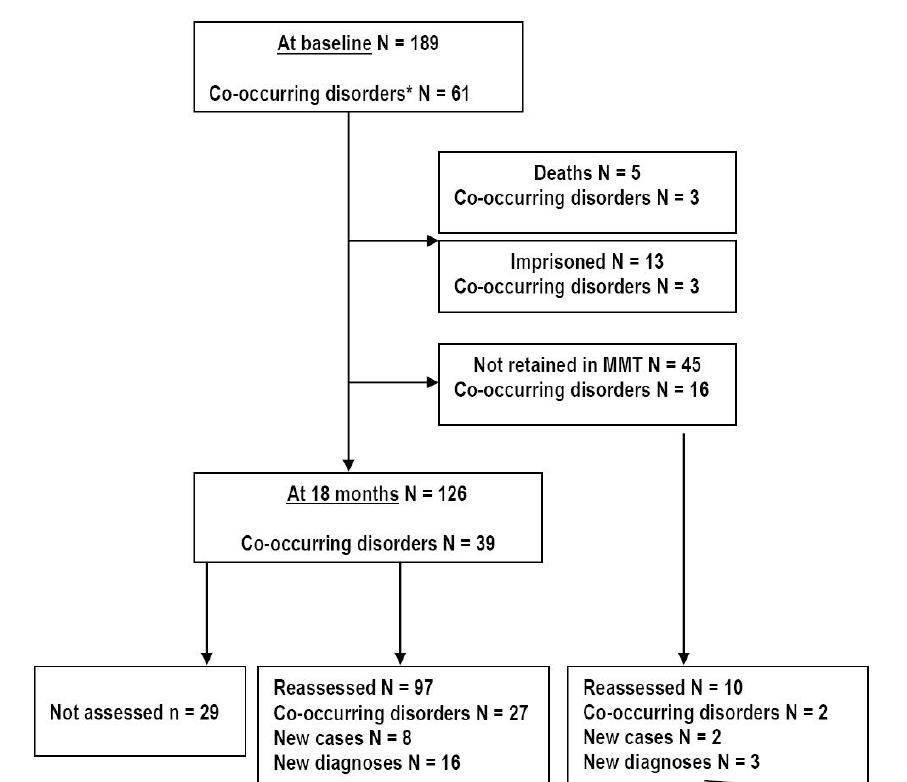
Figure 1. Situation of the 189 opioid dependent patients admitted to a MMT at 18 months